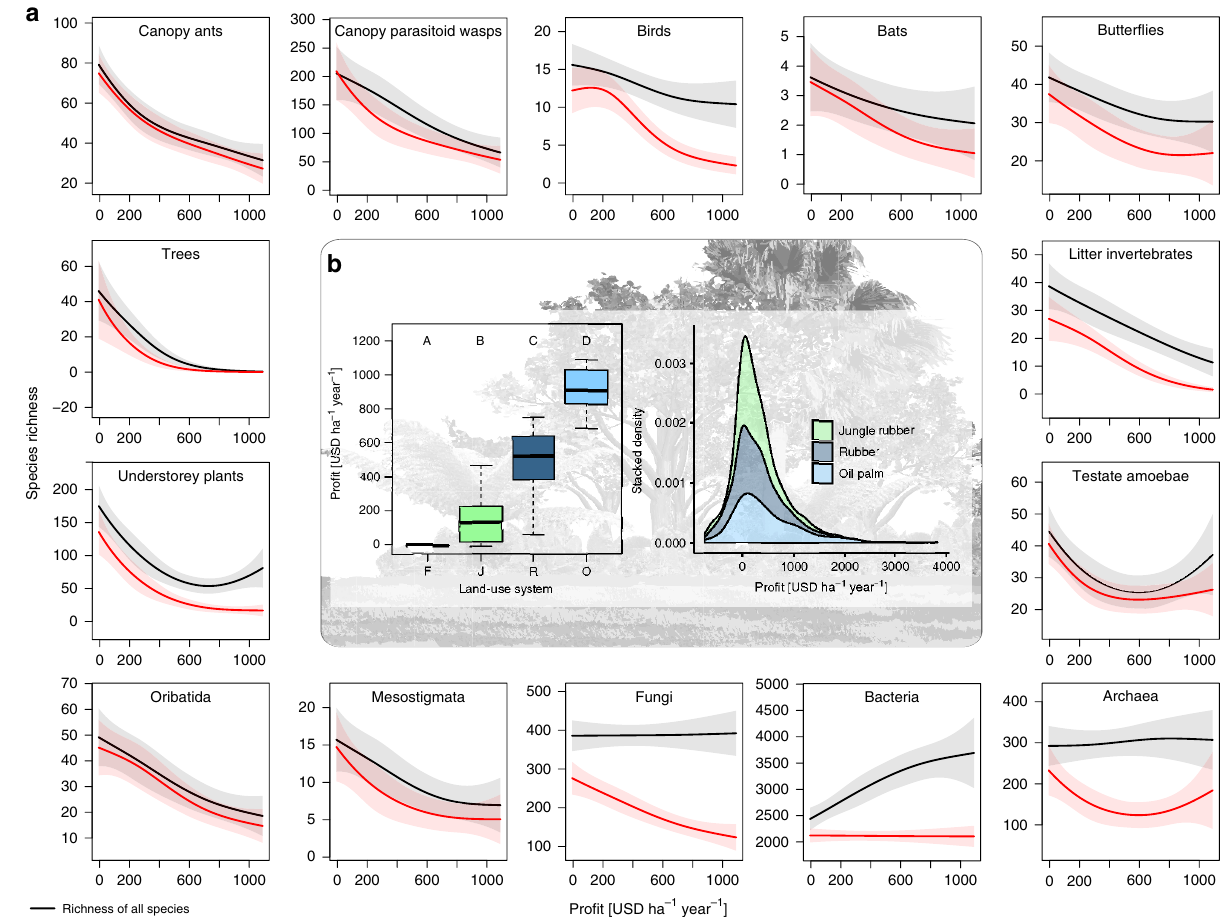
Fig. 2 Species richness changes non-linearly with increasing pro fi ts from land-use transitions by smallholders in an Indonesian landscape. Land-use systems were primary degraded lowland rainforest (F), agroforestry jungle rubber (J), rubber monoculture (R), and oil palm monoculture (O). a Species richness and pro fi t estimates were derived from plot-level data in eight replicates per land-use system. Biodiversity-pro fi t trade-offs were predicted using simulation-extrapolation (SIMEX) of richness-pro fi t relationships (thin lines: SIMEX predictions; shaded areas: 95% con fi dence bands). Predictions for biodiversity were based on species richness of all species (black lines) and of species that were present in rainforest (red lines). b Mean pro fi t per land-use system based on the crop yields in the 32 ecological study plots (left panel) and Kernel density estimates of pro fi t distributions from 701 smallholder household interviews (right panel). Boxplots represent the median (black bars), the 25 – 75% intervals (box edges) and the 1.5 interquartile range (whiskers). Letters indicate signi fi cant differences in pro fi ts of land-use systems (Tukey test, P < 0.05). Source data are provided as a Source Data fi